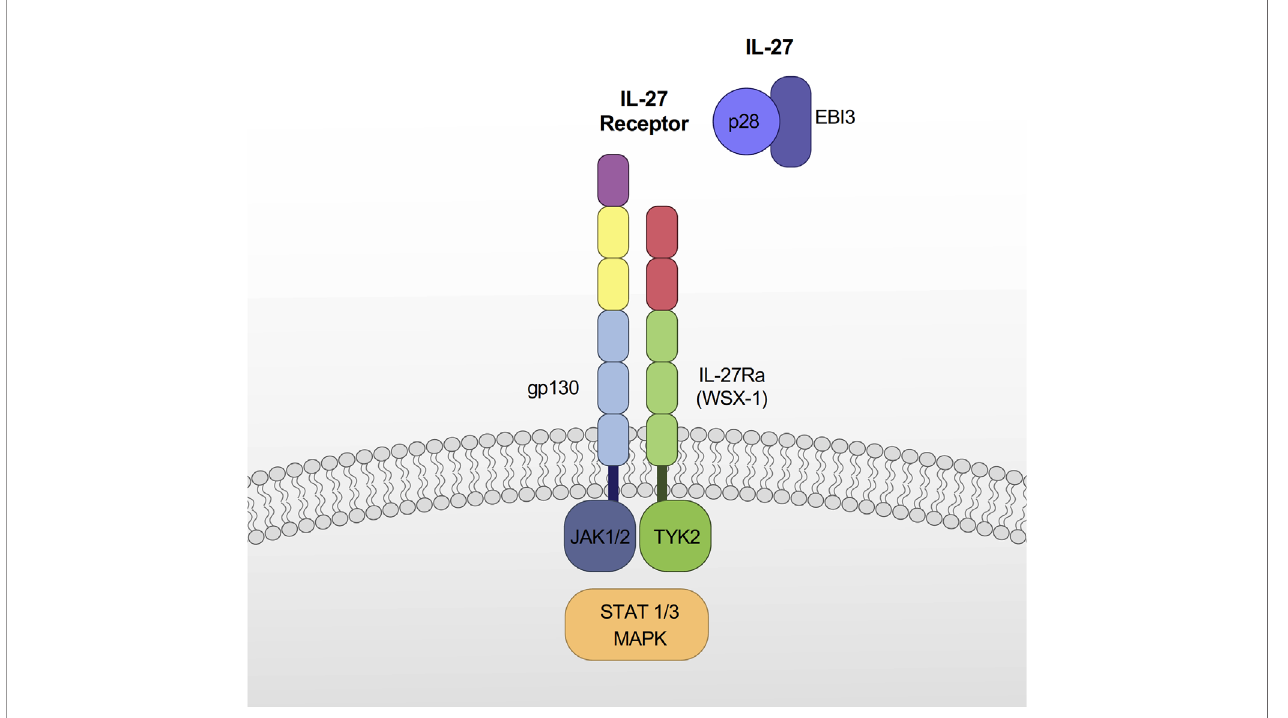
FIGURE 1 | Components of IL-27 and IL-27 receptor. IL-27 is a heterodimeric cytokine composed of IL-27p28 and EBI3. The IL-27 receptor is a heterodimeric cell surface receptor composed of IL-27R a and gp130. IL-27 signaling occurs primarily through a JAK/STAT pathway, which varies depending on immune cell types. IL-27 also signals through MAPK